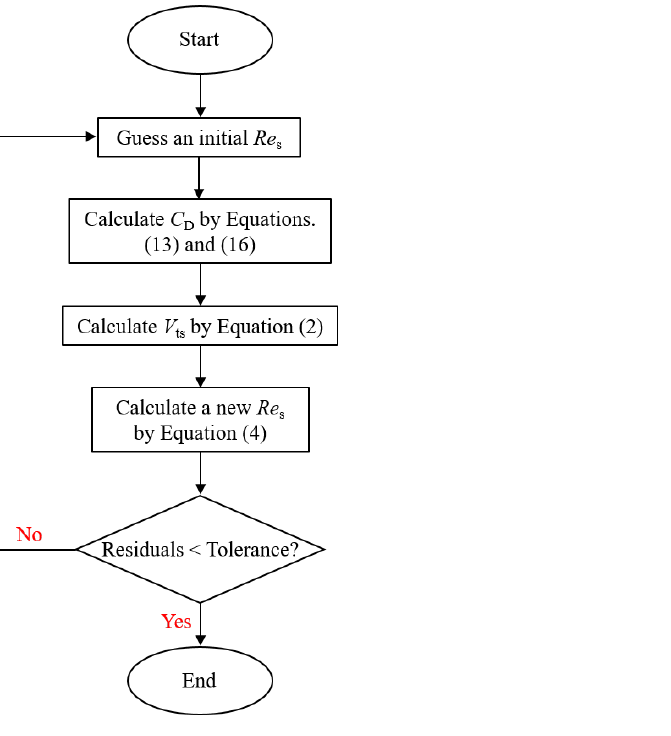
Figure 7. Calculation flow chart of Newton iteration method.